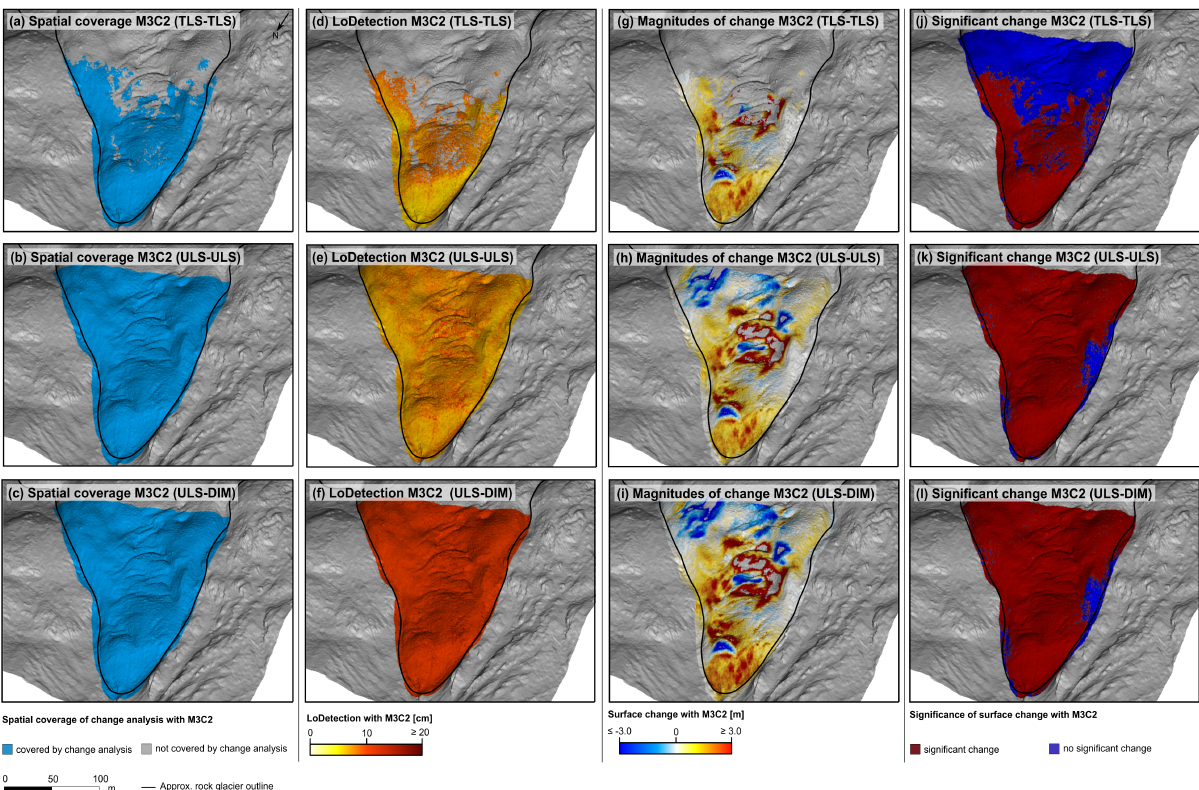
Figure 2. Results of M3C2-based change analysis using point clouds derived from terrestrial laser scanning (TLS), UAV-borne laser scanning (ULS), and UAV-borne photogrammetry using dense image matching (DIM) as input. Spatial coverage (a) - (c), LoDetection (d) - (f), magnitudes of surface change (g) - (i), and significance of surface change (j) - (l) are shown on top of a hillshade derived from airborne laser scanning